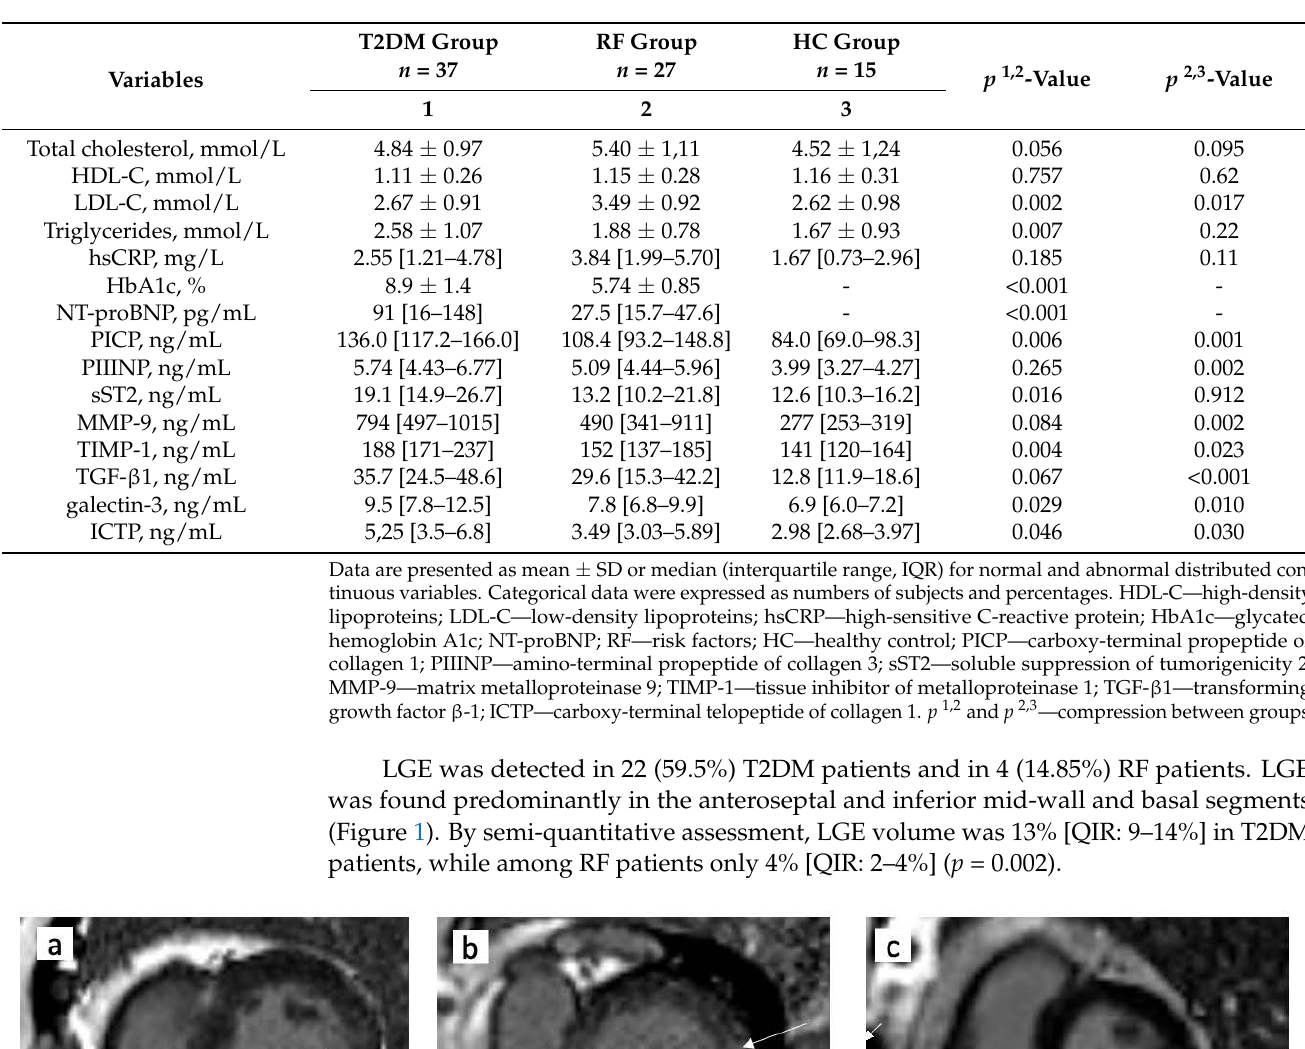
Table 2. Lab tests and fibrosis biomarkers.